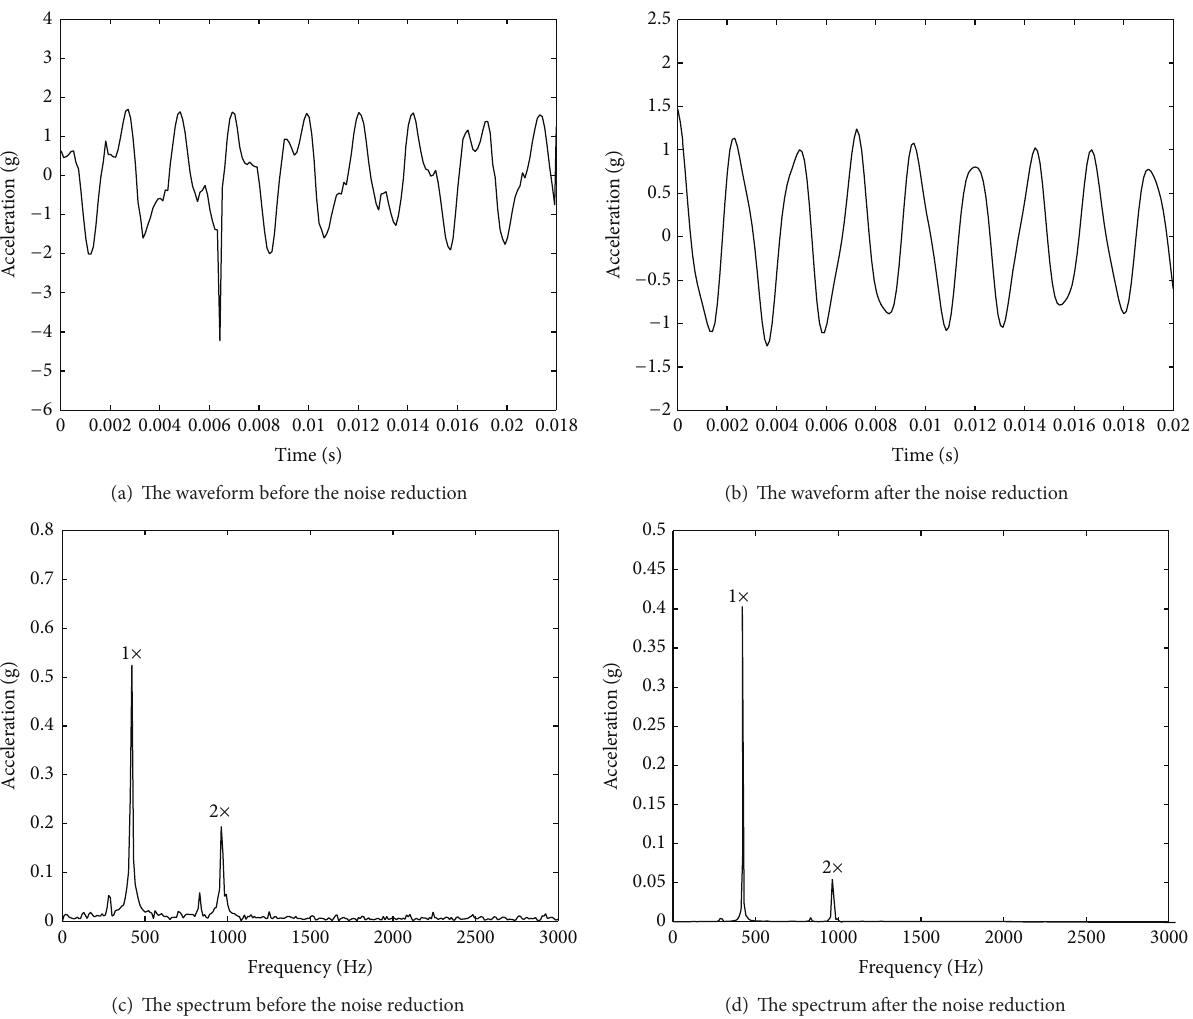
Figure 13: The time domain waveform and frequency spectrum before and after the noise reduction when the rotating speed is 25000 rpm.